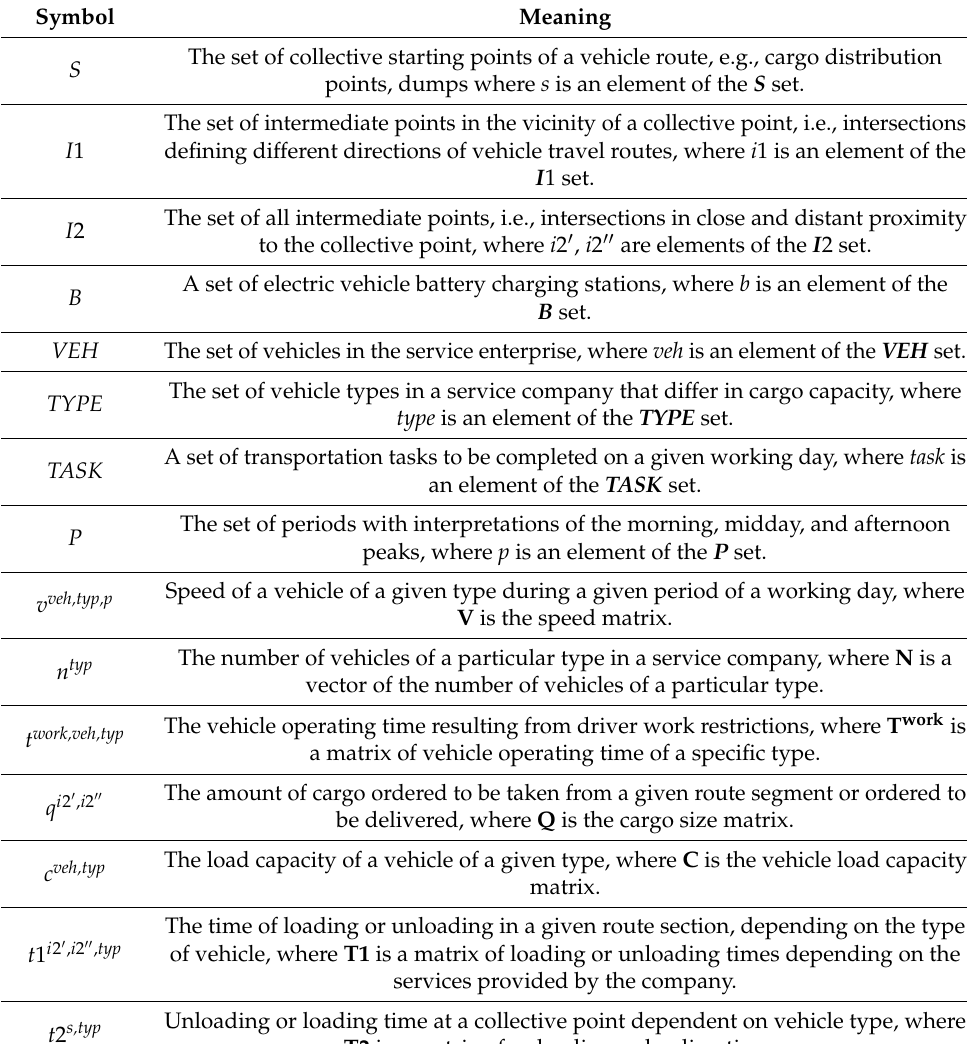
Table 1. Symbols used in the decision